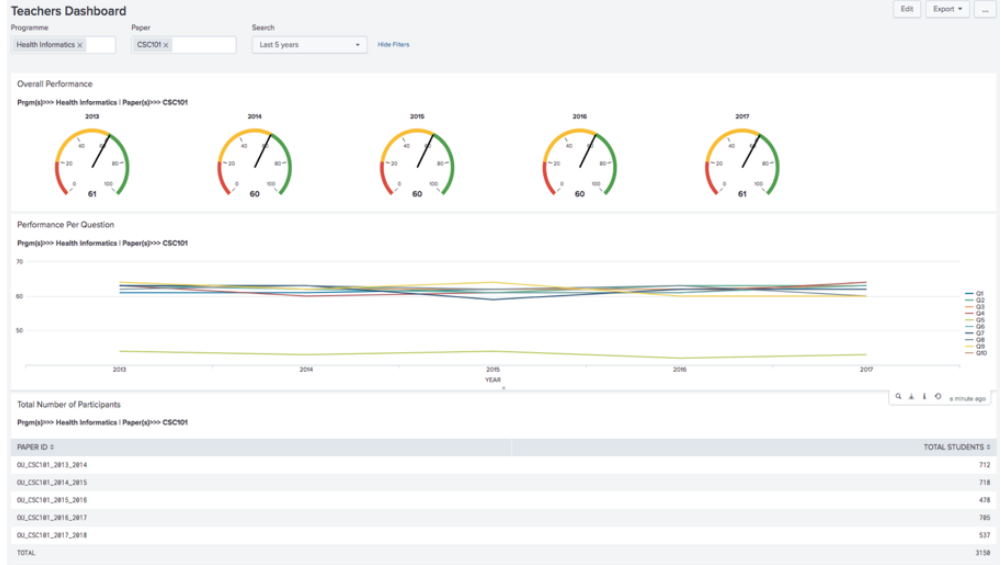
Figure 9. Performance per question of health informatics students that participated in CS101 over a five year